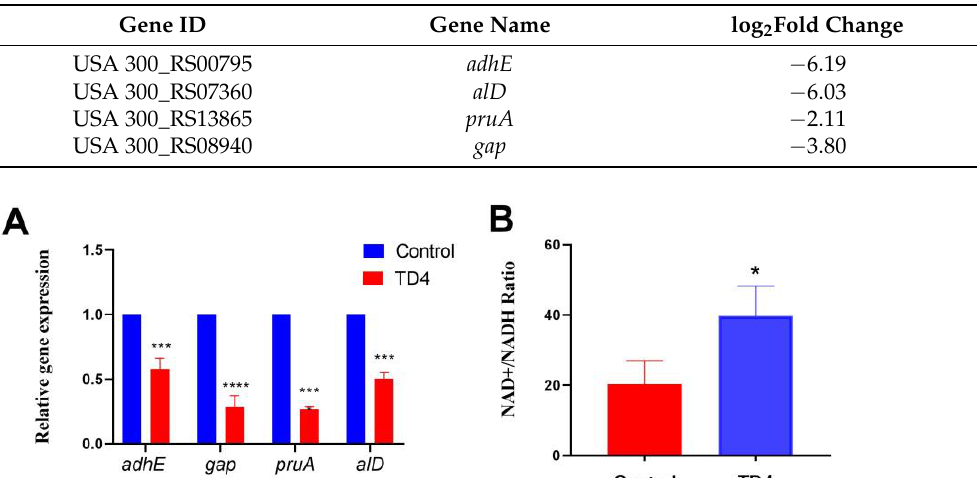
Table 3. Log2 values of significantly down-regulated genes.